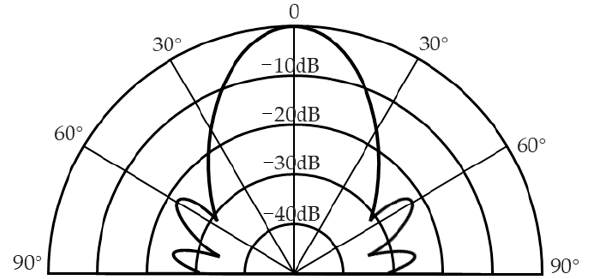
Figure 3. Typical directivity diagram of a transmitting ultrasonic transducer.